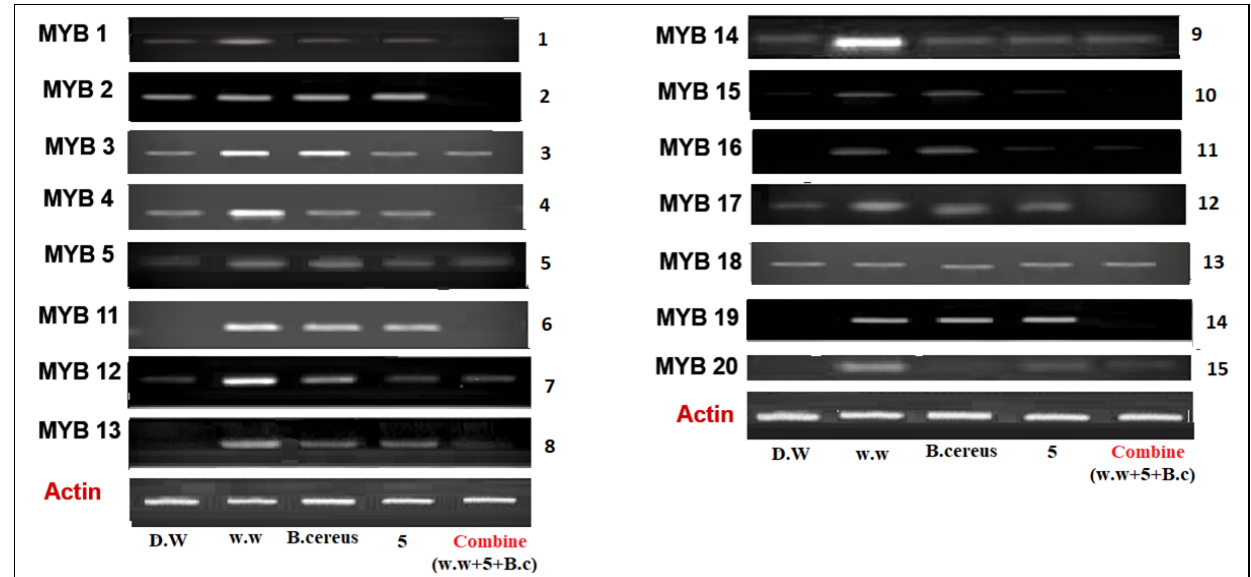
Figure 5. The expression profile of Myeloblastosis (MYB) gene family of rice plants that were grown by the synergistic treatment of bacteria-primed seeds that were grown in 5 mg/L ZnO NPs and HMs-contaminated water. Treatments are DW (distilled water), w.w (wastewater), bio-priming ( Bacillus cereus + w.w), ZnO NPs treatment (5 mg/L + w.w), and combined treatments ( Bacillus cereus + 5 mg/L ZnO NPs + w.w).